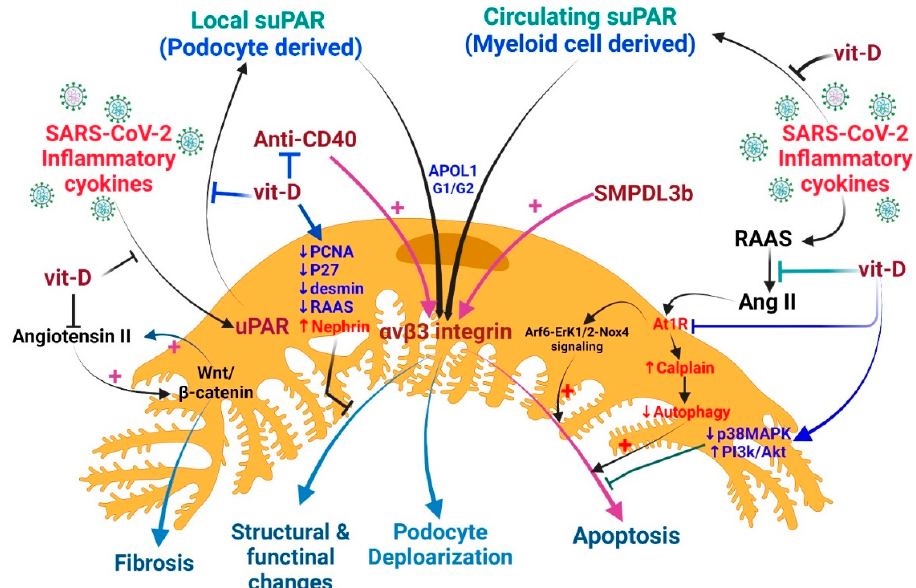
Figure 4. Potential mechanisms by which vitamin D protects podocytes and reduces proteinuria in COVID-19-related AKI. The SARS-CoV-2 infection causes renal podocytes to overproduce suPAR locally and systemically; suPAR activates α v β 3 integrins in podocytes and leads to apoptosis, depolarization, and structural and functional changes in podocytes. At this time, anti-CD40, SMPDL3, and G1/G2 with APOL1 significantly increase the activation of α v β 3 integrins and damage podocytes. Treatment with vitamin D may not only reduce systemic inflammation but also reduce BM-derived leukocyte suPAR. Vitamin D may also reduce the production of uPAR in podocyte cells and protect podocyte function by reducing the deleterious effect of angiotensin II and AT1R signaling. In various animal models, vitamin D reduced desmine (a marker of early podocyte lesion), proliferative nuclear cell antigen (PCNA), p27 kinase inhibitor levels, and the local